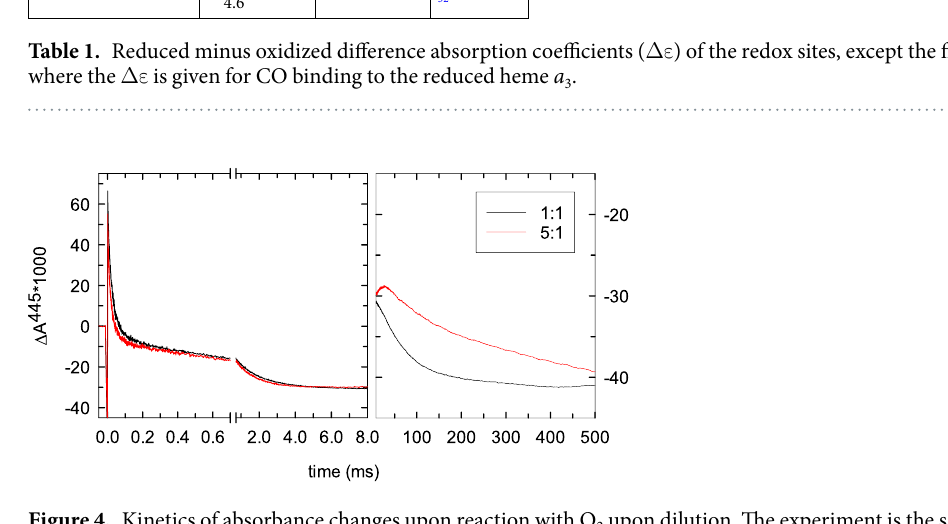
Figure 4. Kinetics of absorbance changes upon reaction with O 2 upon dilution. The experiment is the same as that shown in Fig. 3, but the Cyt c O-containing sample was mixed 1:1 (black) or 1:5 (red) with the O 2 - containing buffer. Note the different absorbance scales in the left and right parts of the graph, respectively. The concentrations of Cyt c O and cyt. c were 5 µ M and 7.5 µ M, respectively.